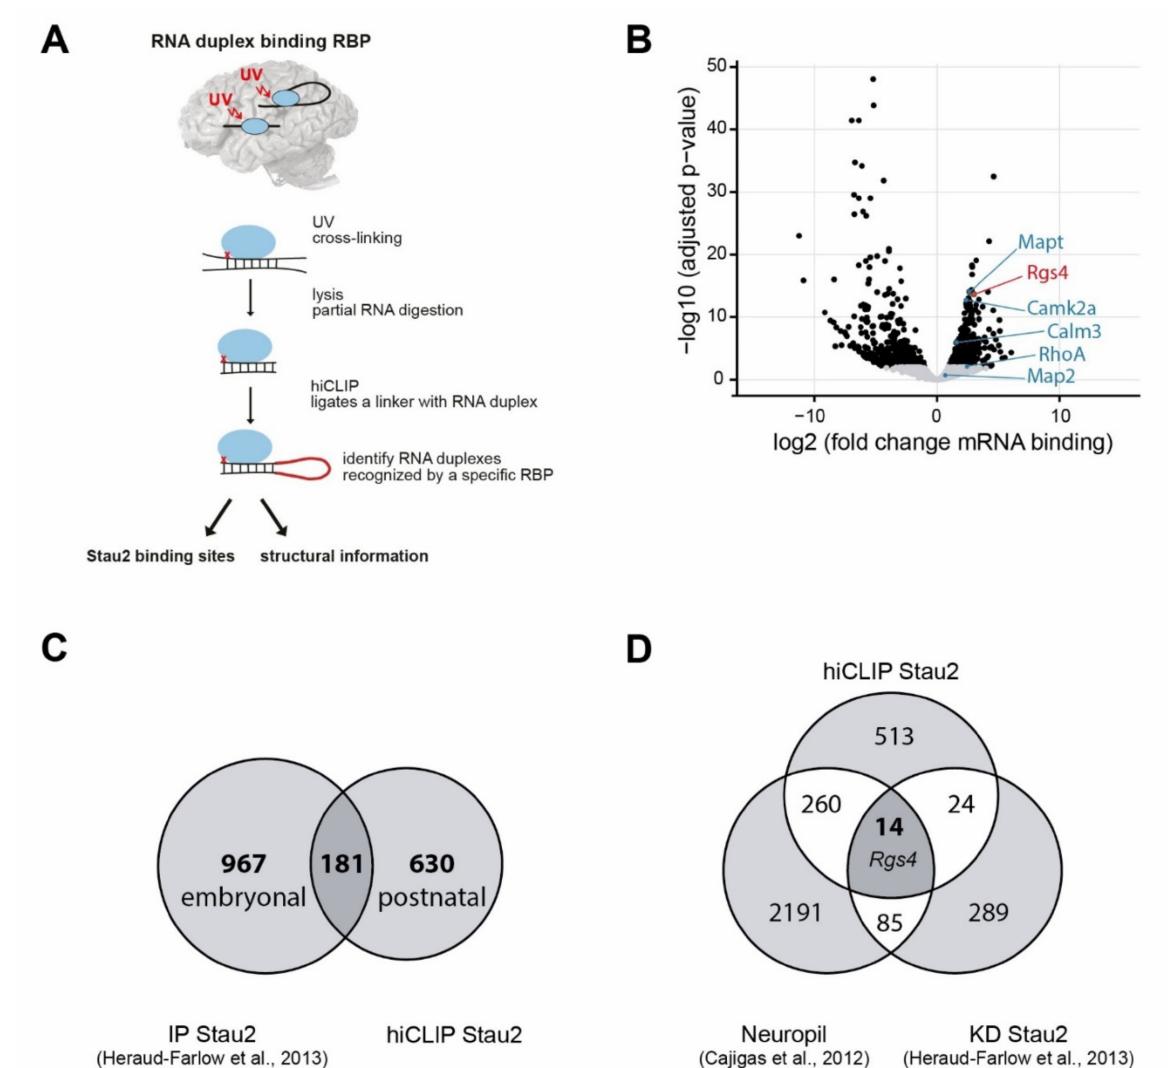
Figure 1. Stau2 RNA duplexes are enriched in dendritically localized transcripts with extended 3 (cid:48) -untranslated region (UTR). ( A ) Schematic overview of hiCLIP (RNA hybrid and individual-nucleotide resolution ultraviolet crosslinking and immunoprecipitation) in brain. ( B ) Volcano plot showing differential enrichment of Stau2 bound mRNA transcripts from postnatal rat brains (P35), comparing Stau2-immunoprecipitation (IP) with input. The previously identified Stau2 target, Rgs4 , known to localize in dendrites, is highlighted in red. Examples of additional Stau2 targets are highlighted in blue: Calm3 , CamK2a , Mapt , Map2 and RhoA . ( C ) Venn diagram displaying the overlap between Stau2-IP mRNA targets from embryonic brain [19] and the newly identified Stau2-hiCLIP targets obtained from postnatal brains (P35). ( D ) Venn diagram displaying the overlap between Stau2 mRNA targets at P35, Stau2 up- and downregulated targets from embryonic brain [19] and neuropil-enriched mRNAs derived from hippocampal CA1 region